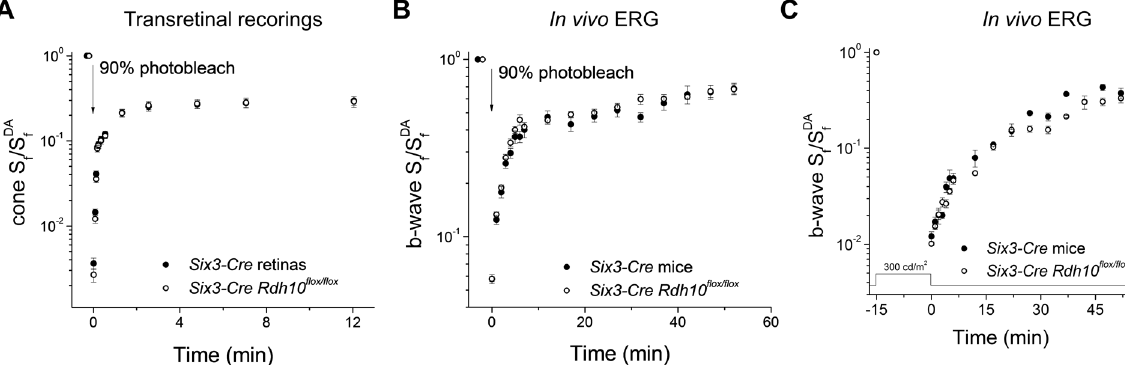
Figure 7. Deletion of RDH10 in the entire retina does not affect cone dark adaptation. ( A ) Normalized cone sensitivity (S f /S fDA ) recovery following 90% pigment photobleach of Six3-Cre control (n = 9, filled symbols) and Six3-Cre Rdh10 flox/flox (n = 8, open symbols) retinas measured by transretinal recordings. ( B ) Normalized cone b-wave sensitivity (b-wave S f /b-wave S fDA ) recovery following a 90% pigment photobleach of Six3-Cre control (n = 12, filled symbols) and Six3-Cre Rdh10 flox/flox (n = 10, open symbols) mice measured by in vivo ERG recordings. ( C ) Normalized cone b-wave sensitivity (b-wave S f /b-wave S fDA ) recovery following a 15 min exposure to 300 cd/m 2 Ganzfeld background light (530 nm wavelength) from Six3-Cre control (n = 4, filled symbols) and Six3-Cre Rdh10 flox/flox (n = 4, open symbols) mice measured by in vivo ERG recordings. All